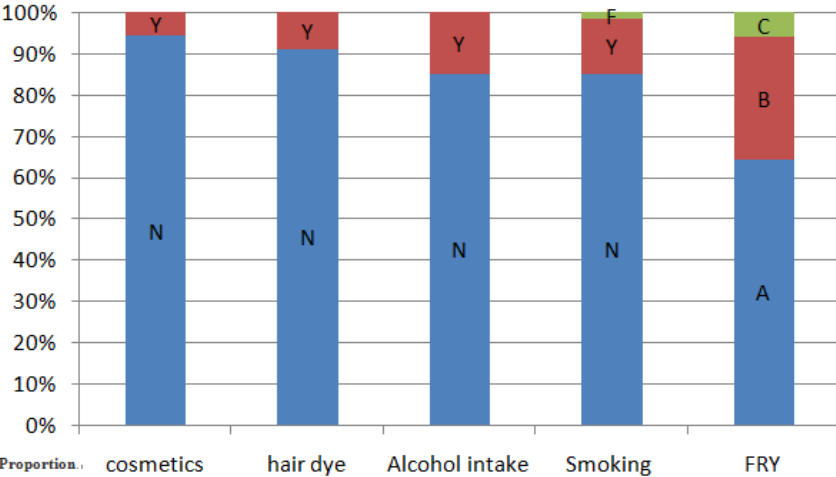
Figure 2. Characteristics of the study population. Univariate analyses of associations between cosmetics, alcohol intake and hair dye with serum concentrations of trace elements were performed using the Wilcoxon test; the Kruskal-Wallis test was used to assess associations between smoking, and consumption of fried foods with serum concentrations of trace elements. N: no; Y: yes; F: former